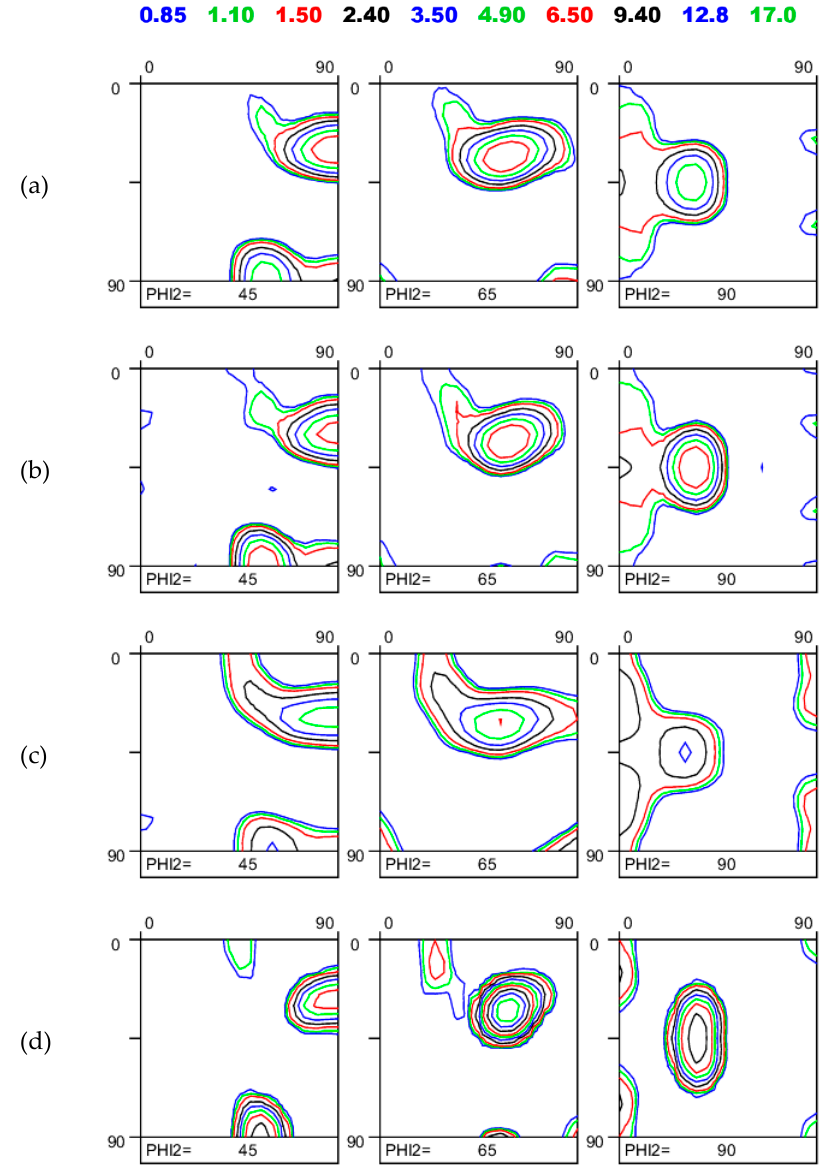
Figure 3. Deformation textures after 86% thickness reduction: ( a ) material A, ODF max = 9.03, TI = 4.02; ( b ) material B, ODF max = 9.81, TI = 4.29; ( c ) material C, ODF max = 6.77, TI = 2.88; ( d ) material D, ODF max = 23.16, TI = 9.29.